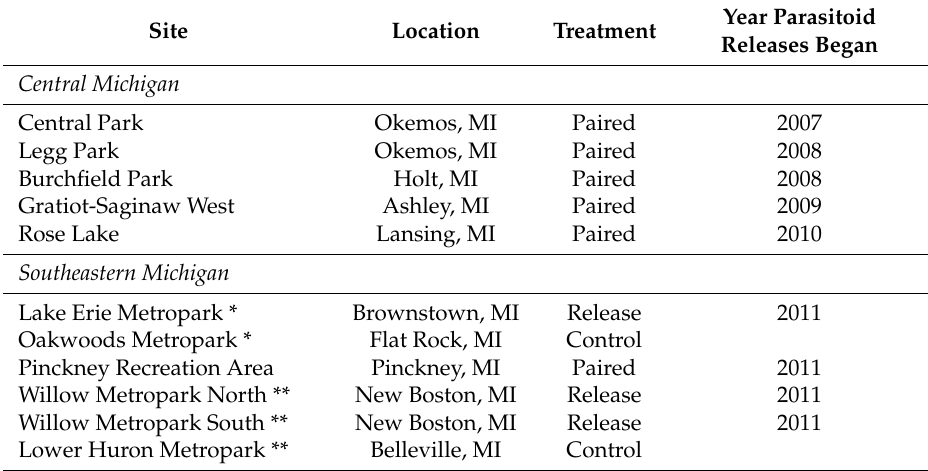
Table 1. EAB biological control study sites in southern Lower